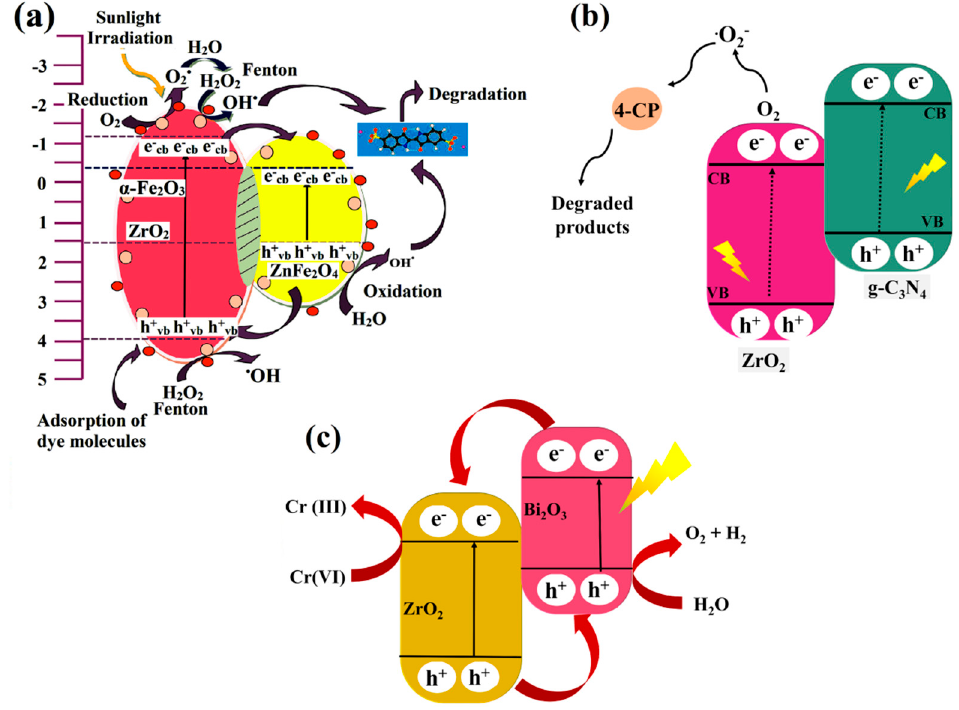
Figure 6. ( a ) Photodegradation pathway of indigo carmine dye under sunlight exposure for ZrO 2 /ZnFe 2 O 4 composite, reprinted with permission from Elsevier (License NO. 5333060926293) [31], ( b ) schematic representation of charge carriers’ separation on 30 wt% ZrO 2 /g-C 3 N 4 composites under light illumination [65], and ( c ) systematic presentation of photocarriers transfer in Bi 2 O 3 -ZrO 2 hybrid in presence of visible light, reproduced with permission from Elsevier (License NO. 5333060789631) [64].